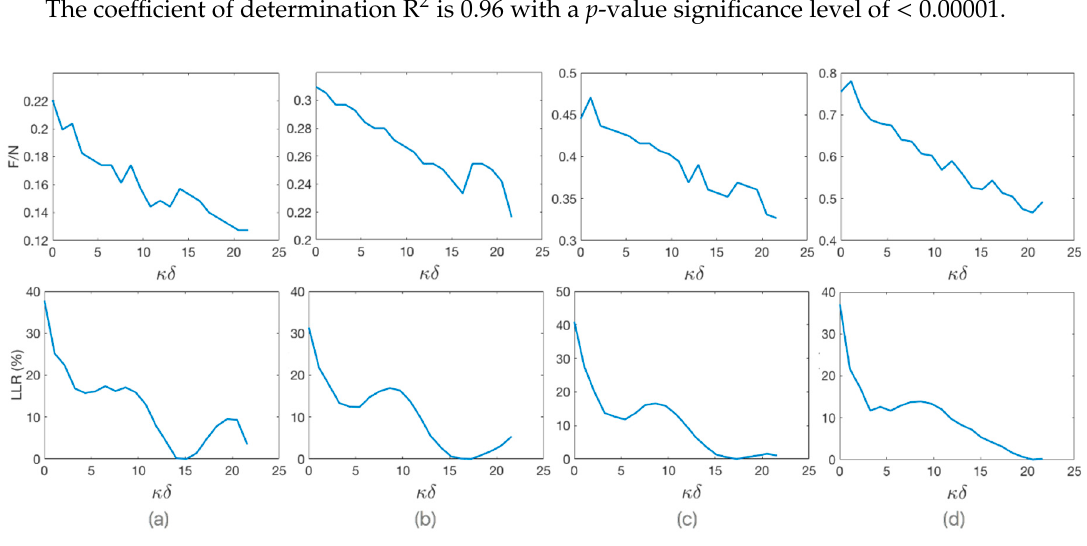
Figure 4. (Top) Value of F / N and (Bottom) relative loss of lateral resolution, both, vs. stand-o ff given in number of wavelengths ( κδ ) for 445 kHz PDMS-based axicon lens with di ff erent angles. ( a ) φ = 140 ◦ ; ( b ) φ = 150 ◦ ; ( c ) φ = 160 ◦ ; ( d ) φ = 170 ◦